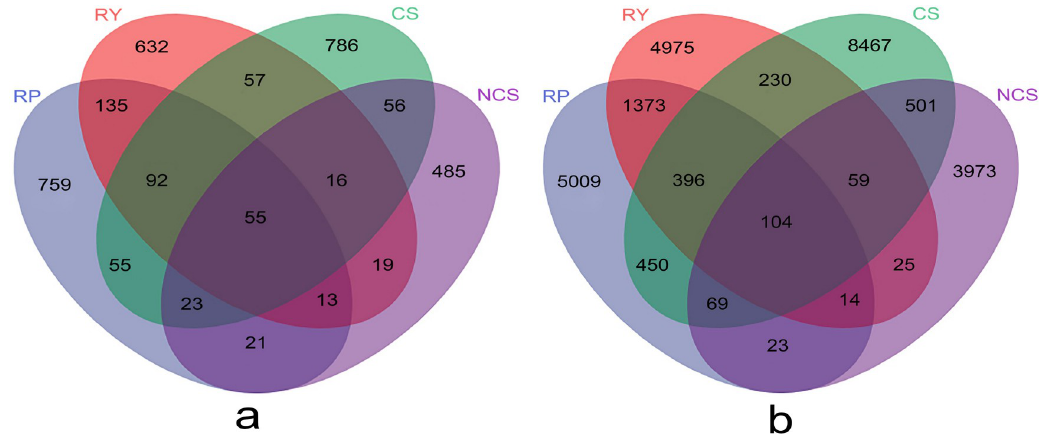
Fig 4. Venn diagram of unique and shared fungal (a) and bacterial (b) ASVs among different soil and rhizosphere samples. Each colour represents a group, and the numbers indicate the quantities of ASVs contained in the block.